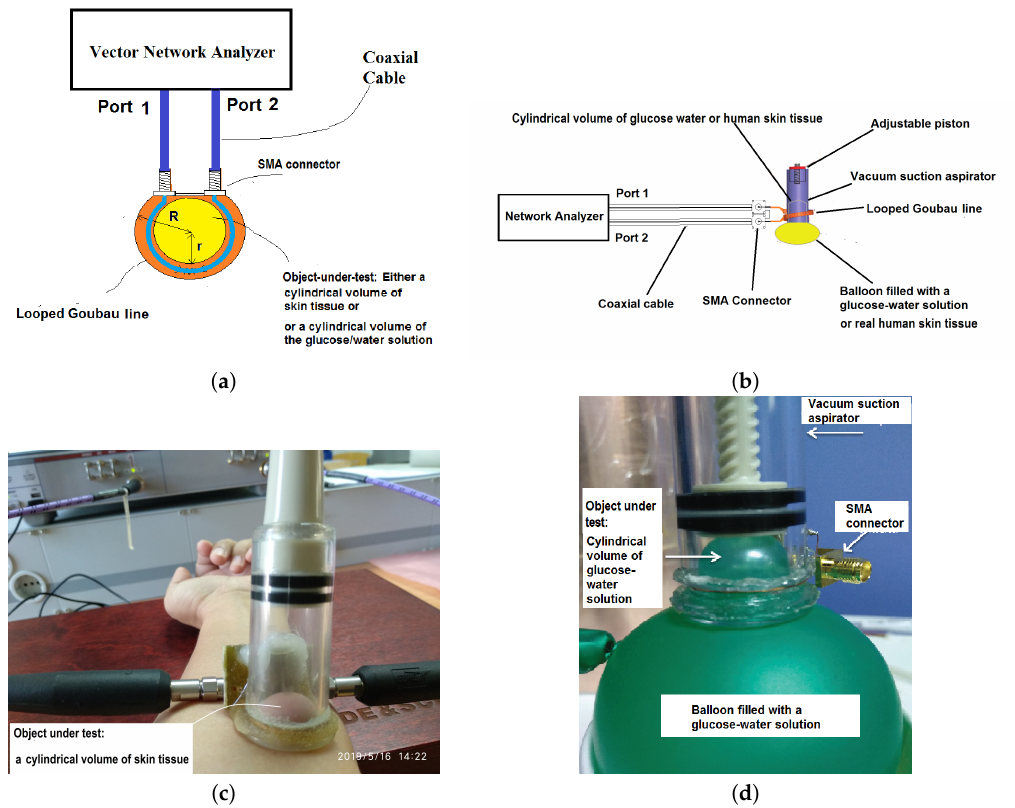
Figure 1. ( a ) Top view of the experimental setup for measuring the glucose concentration; ( b ) side view of the experimental setup for measuring the glucose concentration; ( c ) the proposed glucose sensor in an in-vivo experiment; ( d ) the proposed glucose sensor in an ex-vivo